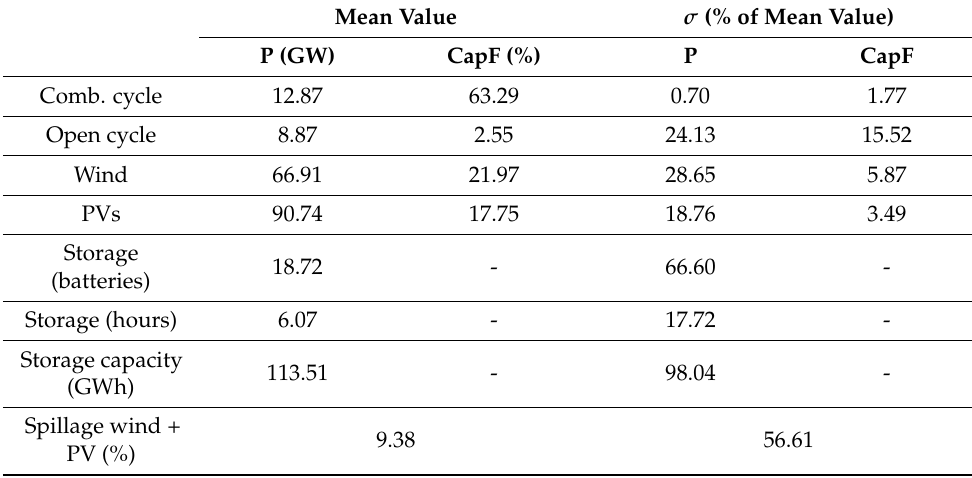
Table 5. Sensitivity analysis with the considered